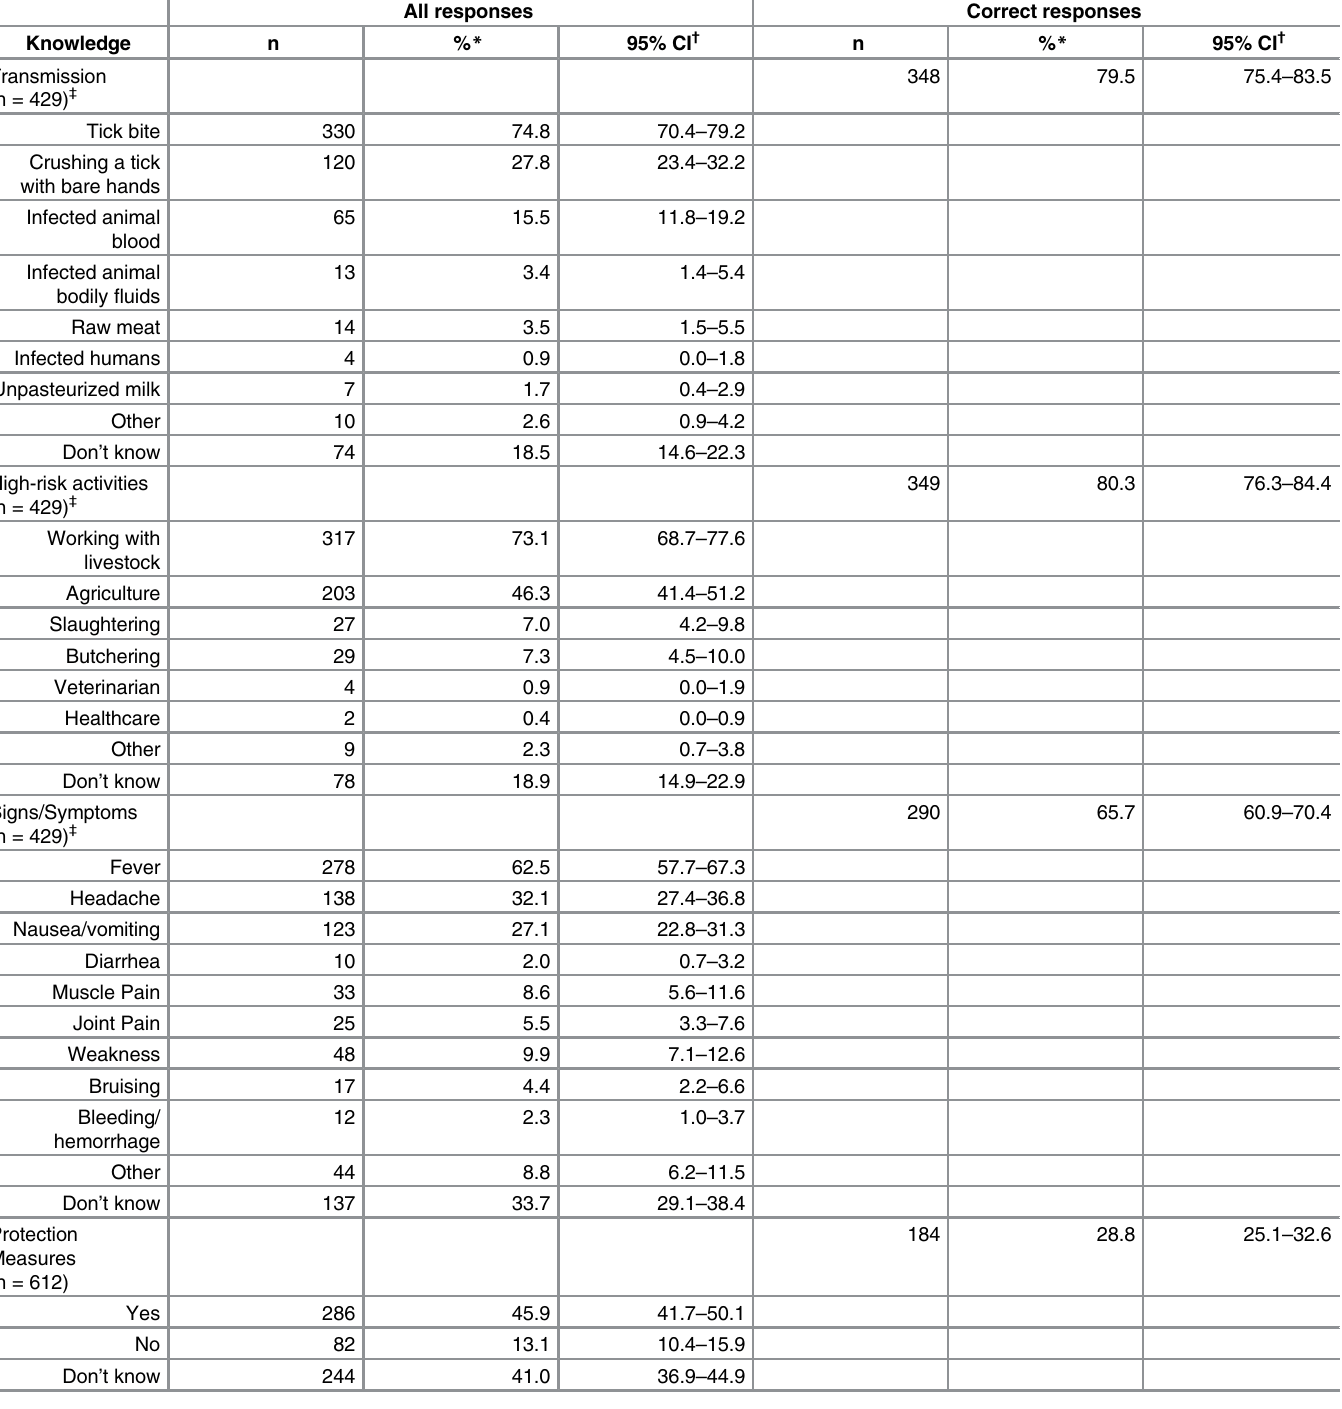
Table 2. Knowledge of Crimean-Congo hemorrhagic fever (CCHF) among survey participants during an investigation of the 12 rural villages reporting at least one 2014 CCHF case from January to September 2014 in